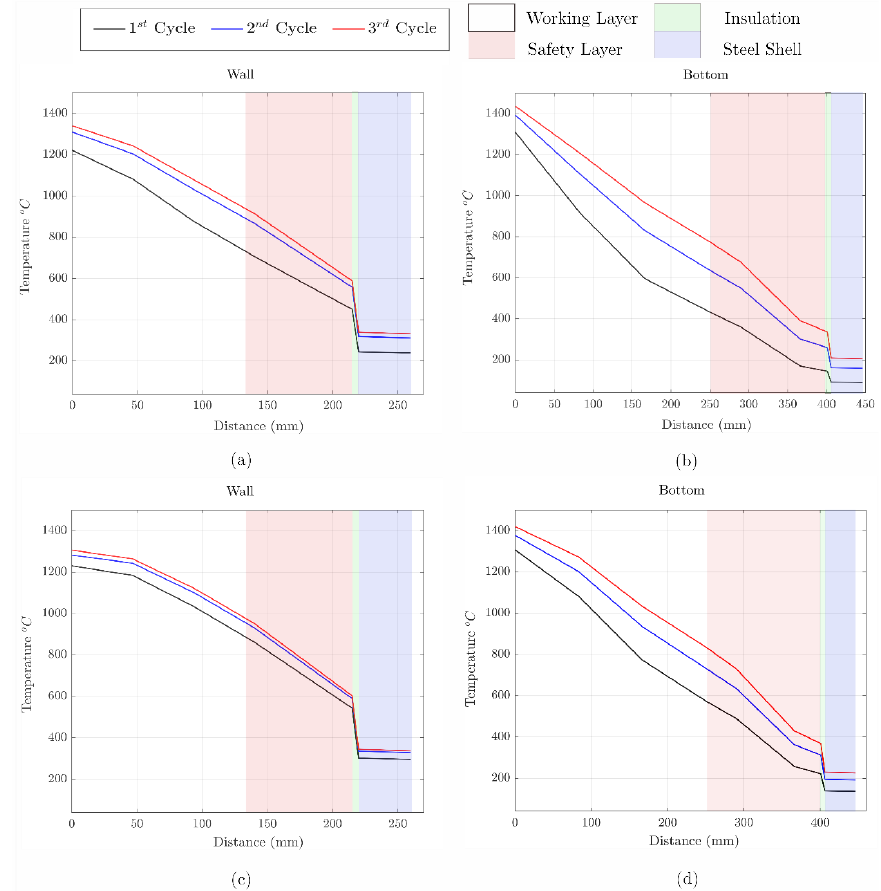
Figure 9. Temperature gradient through the thickness of the steel ladle’s wall and bottom at ( a , b ) end of step 2 and ( c , d ) end of step 4 of three full ladle’s thermal cycles (see Table 3 for more details about each step of the thermal cycle).